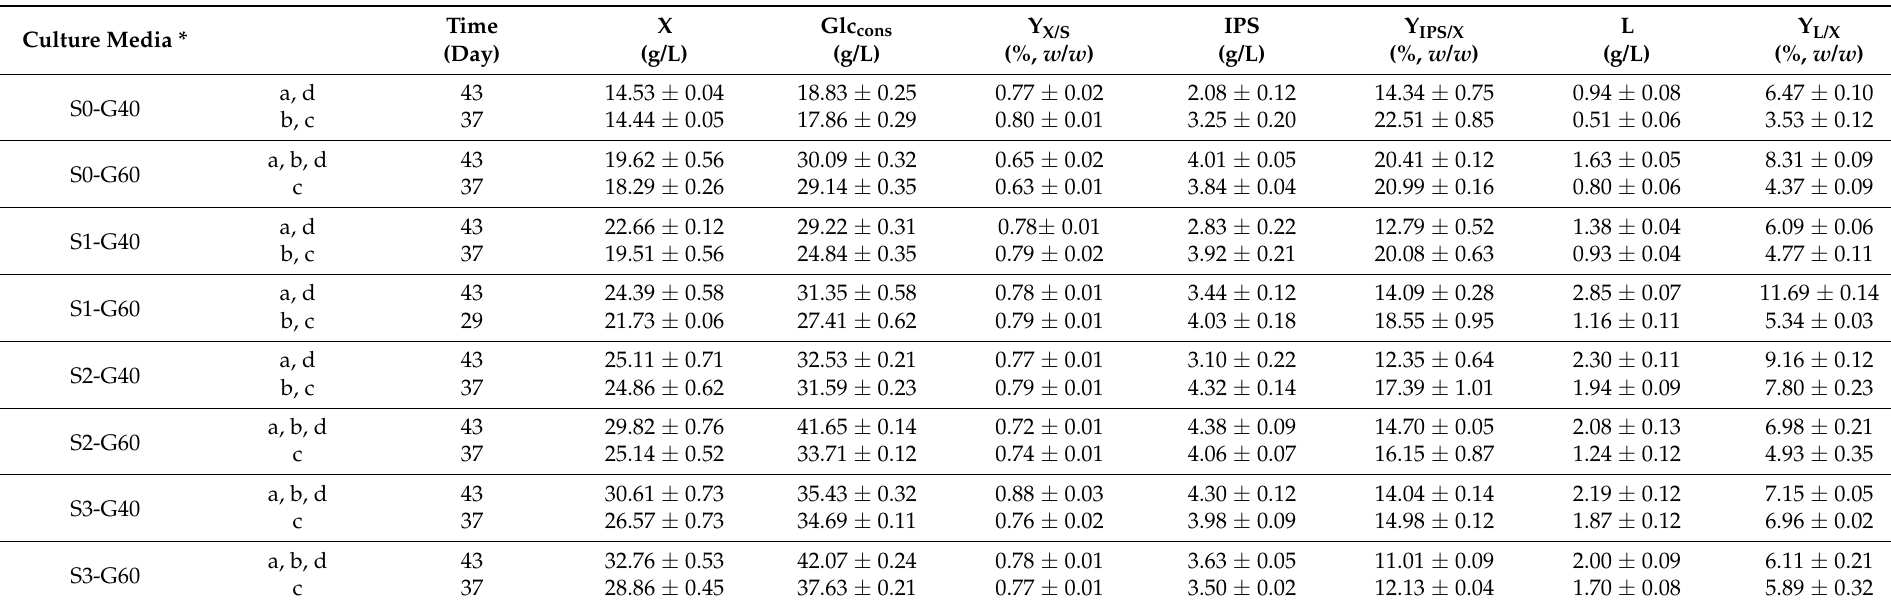
Table 3. Total results of biomass, IPS and lipids production, phenolic removal and decolorization of P. pulmonarius in batch-liquid state fermentation cultures, in synthetic media containing commercial glucose and OMWs with various phenolics concentrations. Representation of dry biomass (X, g/L), consumed glucose (Glc c , g/L), IPS (in g/L and w / w ) and total cellular lipids (L, in g/L and w / w ) at the following different fermentation points of each trial: (a) when the maximum biomass (X max , g/L) was produced; (b) when the maximum IPS amount (Y IPS/Xmax, g/L) was synthesized; (c) when the maximum IPS in dry weight (Y IPS/Xmax, %, w / w) value was achieved and (d) when the maximum total lipid in dry weight (Y L/Xmax, %, w / w ) value was recorded. Culture conditions: growth on 100-cc flasks,